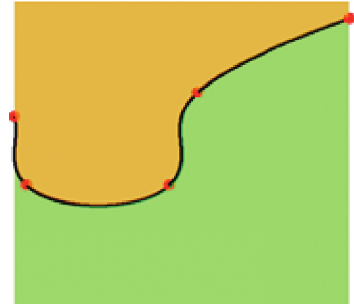
Figure 5: xy -view of intersection along with boundary and turning